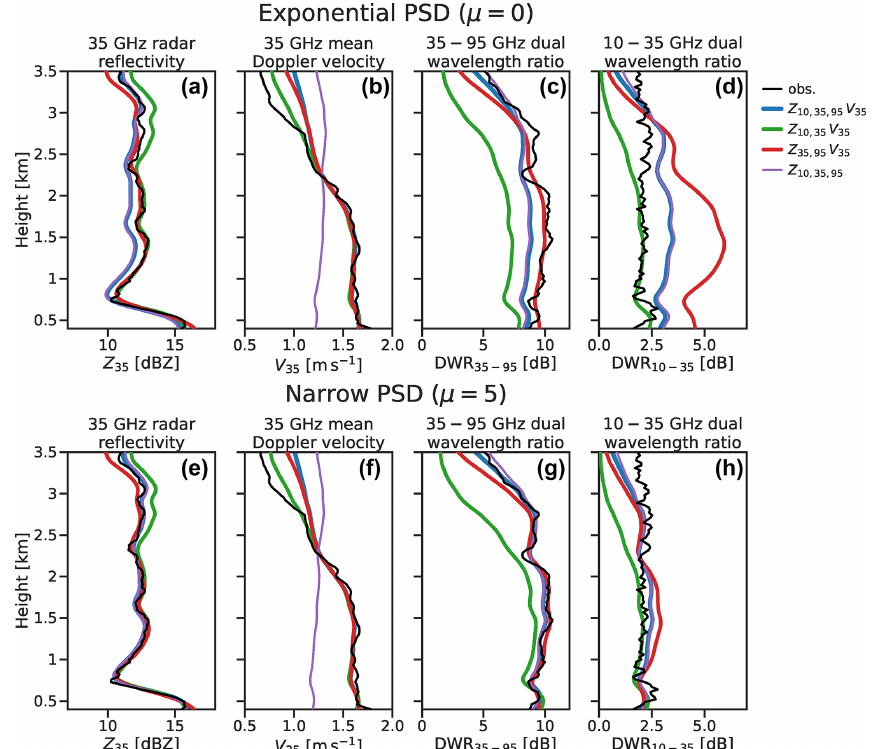
Figure 8. Profiles of observed and forward-modelled radar variables for retrievals of a selected profile during the rimed snow regime. Retrievals assuming (a–d) an exponential PSD are compared against those with (e–h) a narrow PSD with µ =